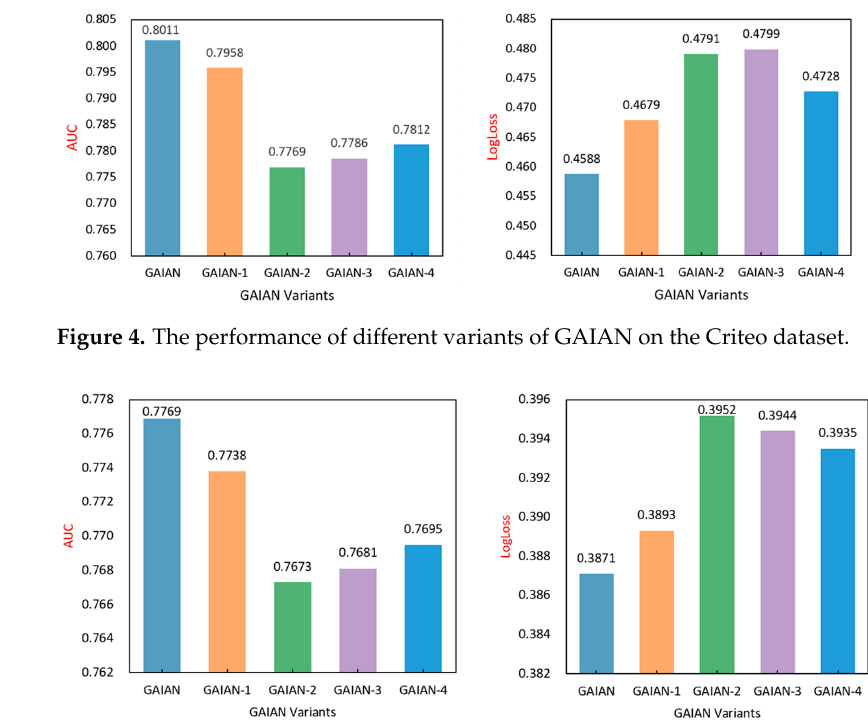
Figure 5. The performance of different variants of GAIAN on the Avazu dataset.